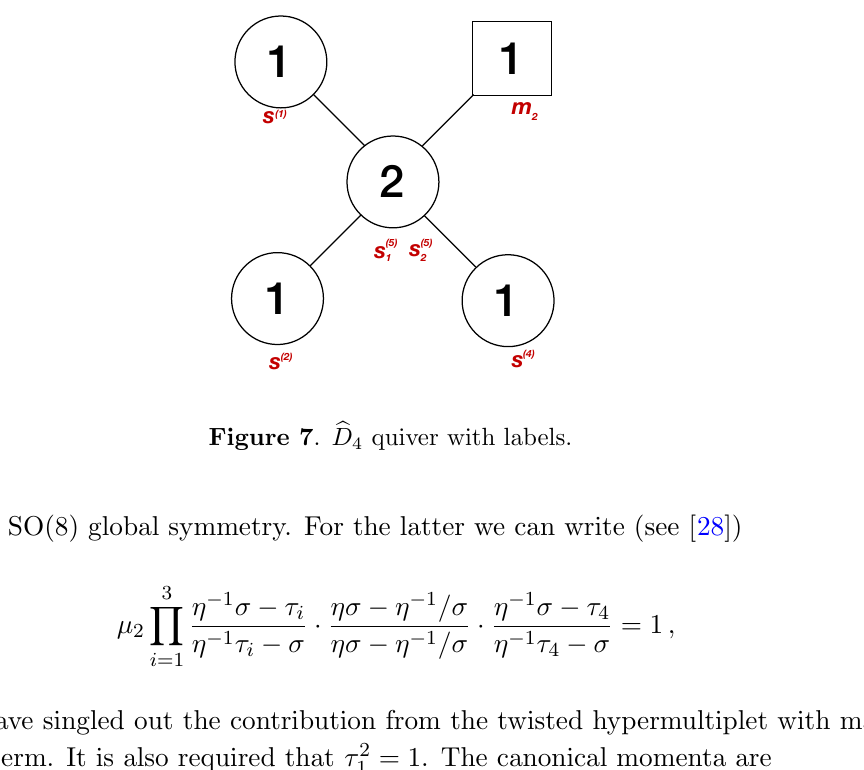
Figure 6 . Mirror dual A 3 and A 1 quivers with framing.